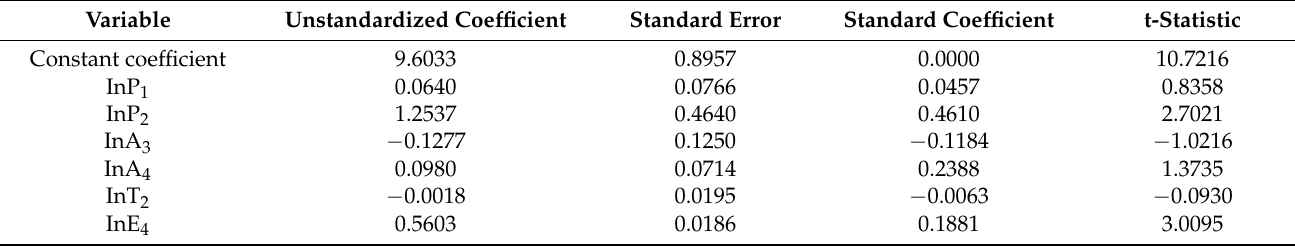
Table 8. Zhejiang Model Test